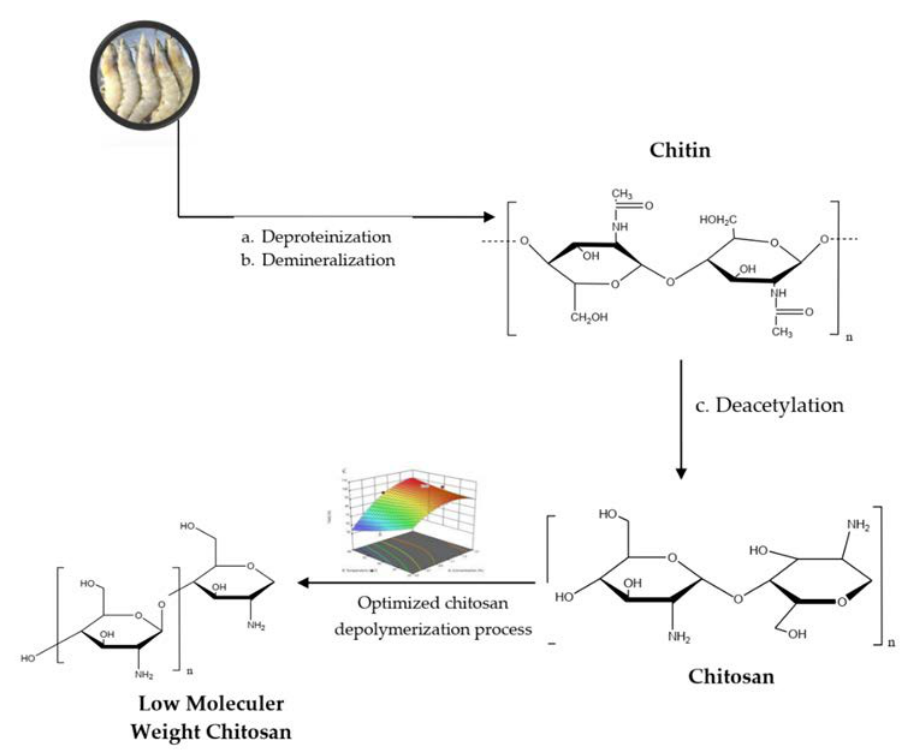
Figure 1. Strategy for production of low molecular weight chitosan by depolymerization.